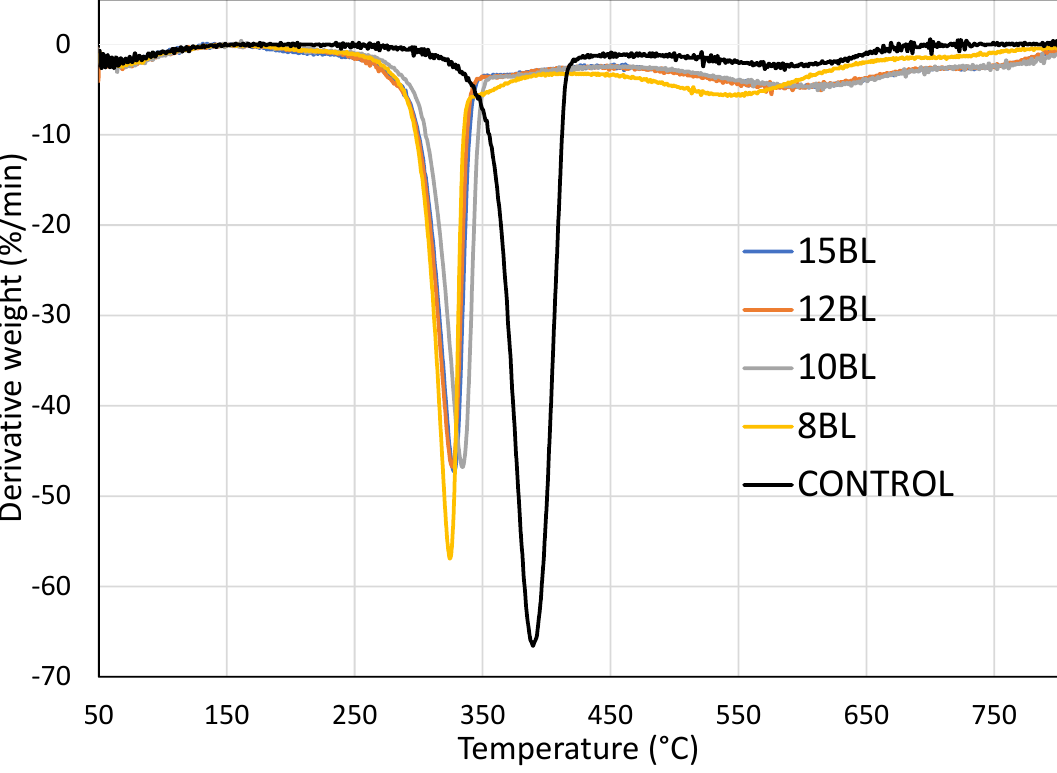
Figure 4. Derivative weight as a function of temperature for untreated and LbL-treated